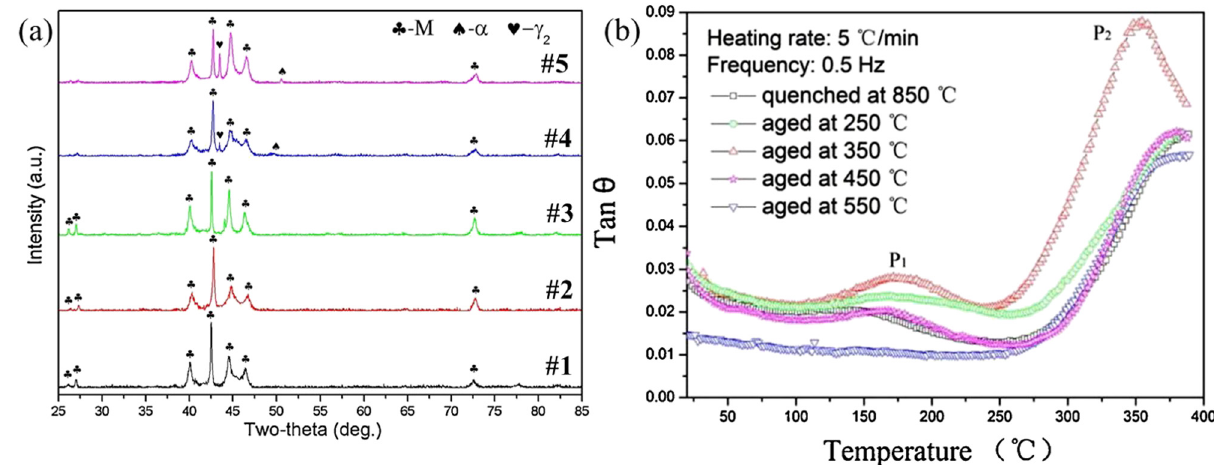
Figure 14: Cu – Al – Mn alloy treated at di ff erent temperatures: ( a ) XRD patterns and ( b ) the damping properties [ 138 ]